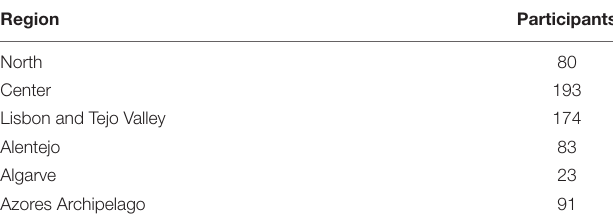
TABLE 2 | Participants by